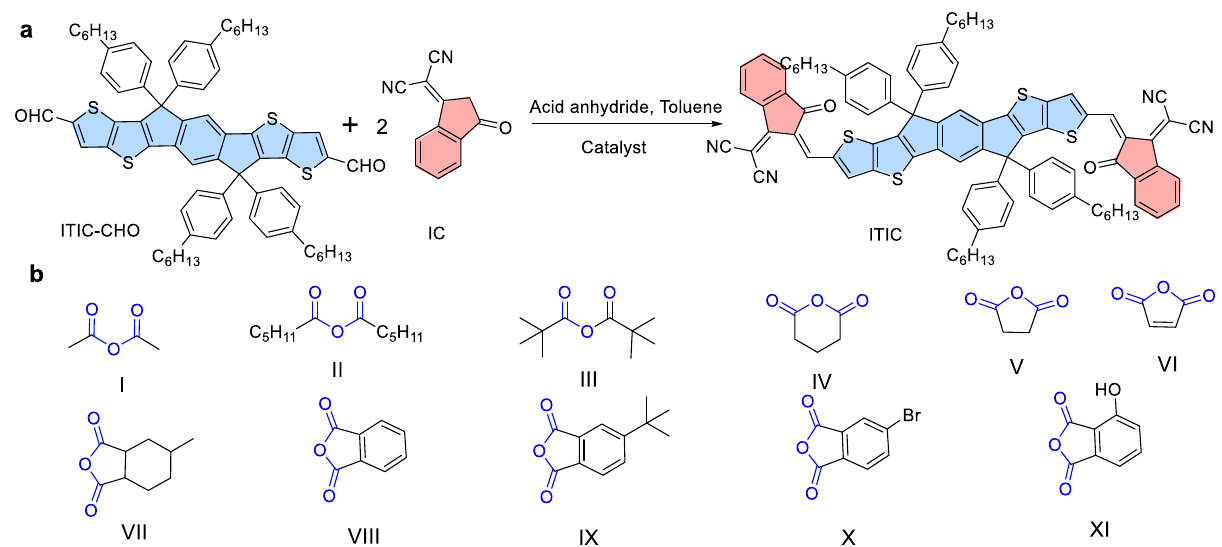
Fig. 1 The synthesis of SMAs. a The synthetic rout of ITIC, the bule color represents D unit and the red color represents the A unit. b The acid anhydrides explored, acid anhydride groups are indicated with blue color.